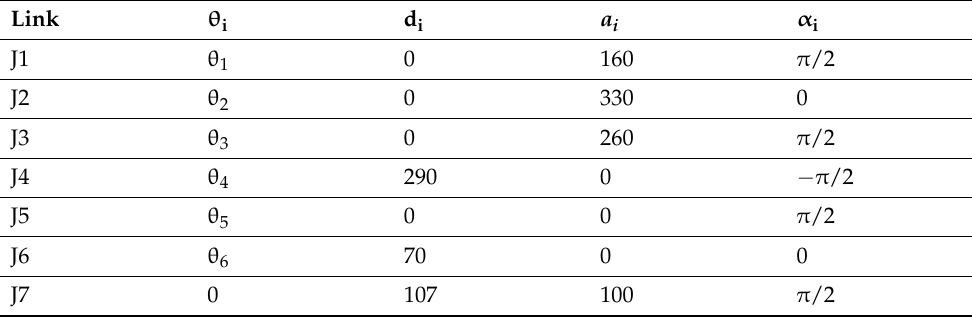
Table 2. DH parameters for the LR-Mate 200iD/4S